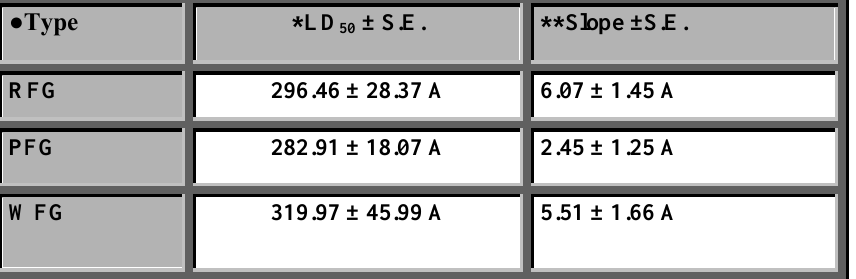
*LD was compared with the two others. 50 ** Slope was compared with the two